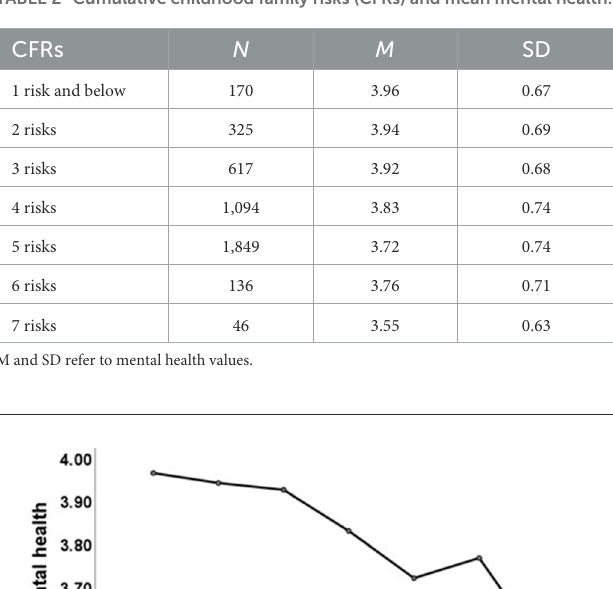
TABLE 2 Cumulative childhood family risks (CFRs) and mean mental health.